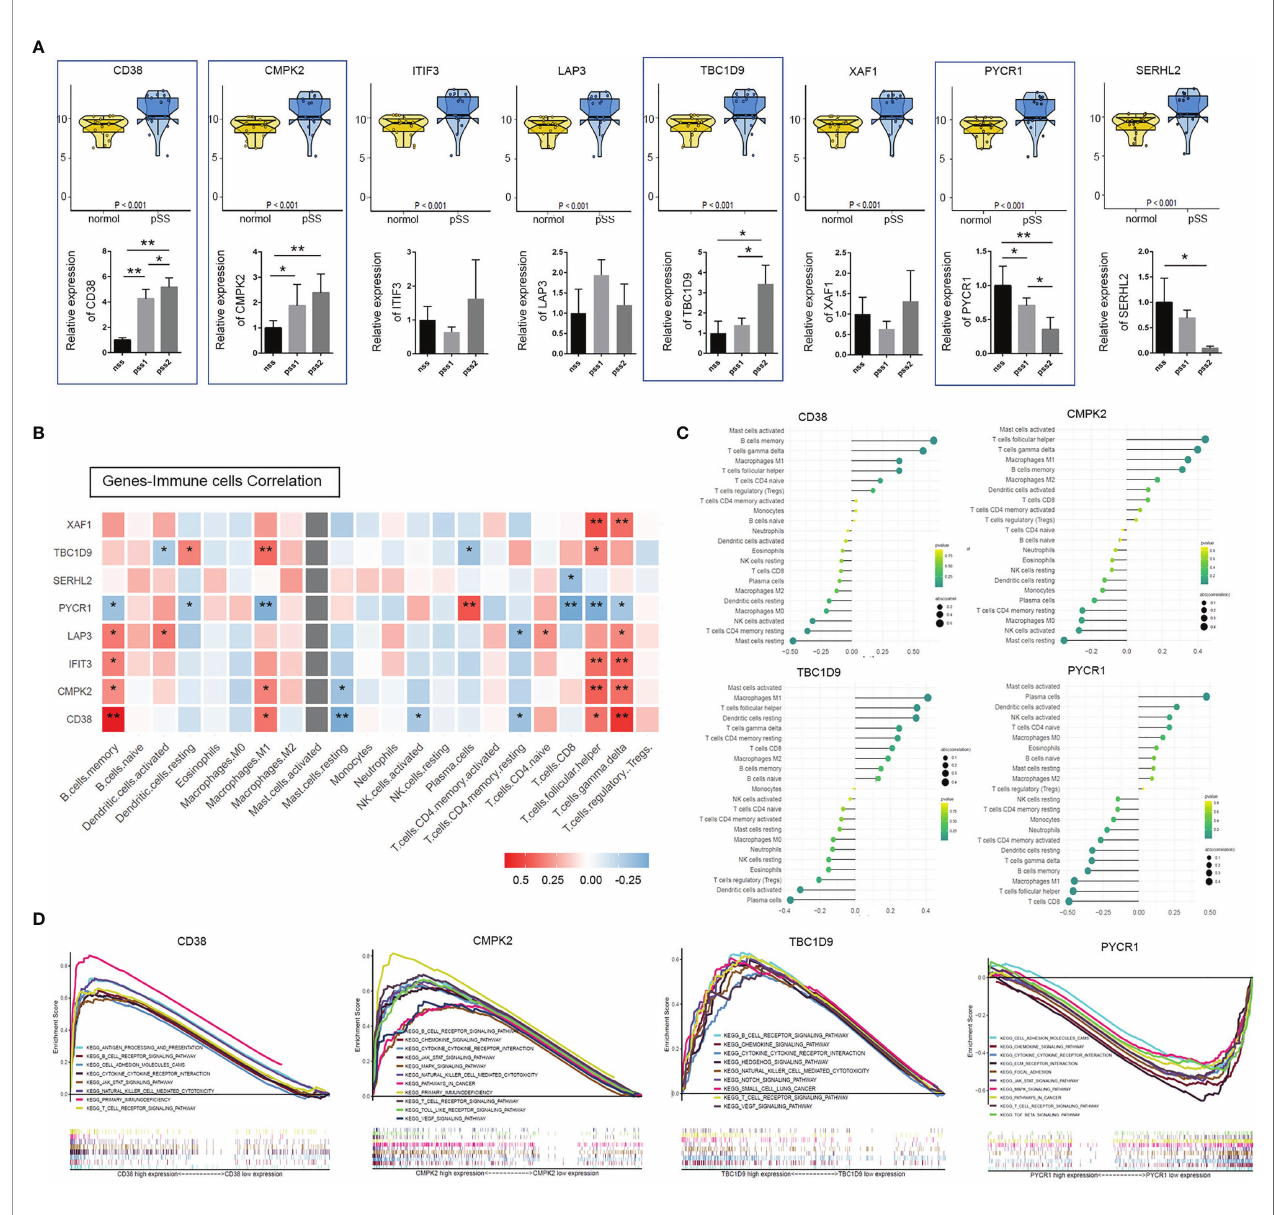
FIGURE 3 | Identi fi cation and validation of mitochondria & immune-related hub genes. (A) Top: expression analyses of the 8 mitochondria-related genes (CD38, CMPK2, ITIF3, LAP3, TBC1D9, XAF1, PYCR1, and SERHL2) in normal and pSS patient cohorts were illustrated using the R package “ ggpubr ” function (p < 0.001, Wilcox test) (NCBI-GEO database). Bottom: above genes identi fi ed by quantitative real-time PCR from our own cohort. Data shown were normalized to Actin expression and were relative to expression in the non-pSS (n = 3, error bars represent mean ± SD, *p < 0.05, and **p < 0.01 by Student ’ s t test). (B) Heatmap shows Spearman correlation between hub genes and immune cells. (C) The lollipop chart of CD38, CMPK2, TBC1D9, and PYCR1 demonstrates the correlation between genes and immune cells, an extension of Figure 4B . Lollipop size corresponds to the strength of this correlation. (D) Gene Set Enrichment Analysis (GSEA) of KEGG pathway enrichment for CD38, CMPK2, TBC1D9, and PYCR1 high-expression group versus low-expression